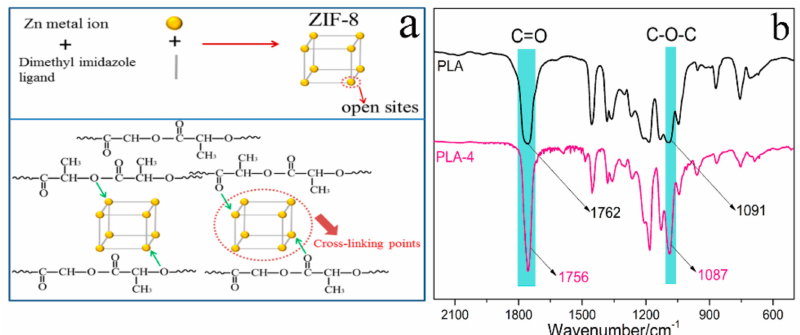
Figure 4. The enhancement mechanism ( a ) and Fourier transform infrared spectroscopy (FTIR) curves ( b ) the nanocomposite